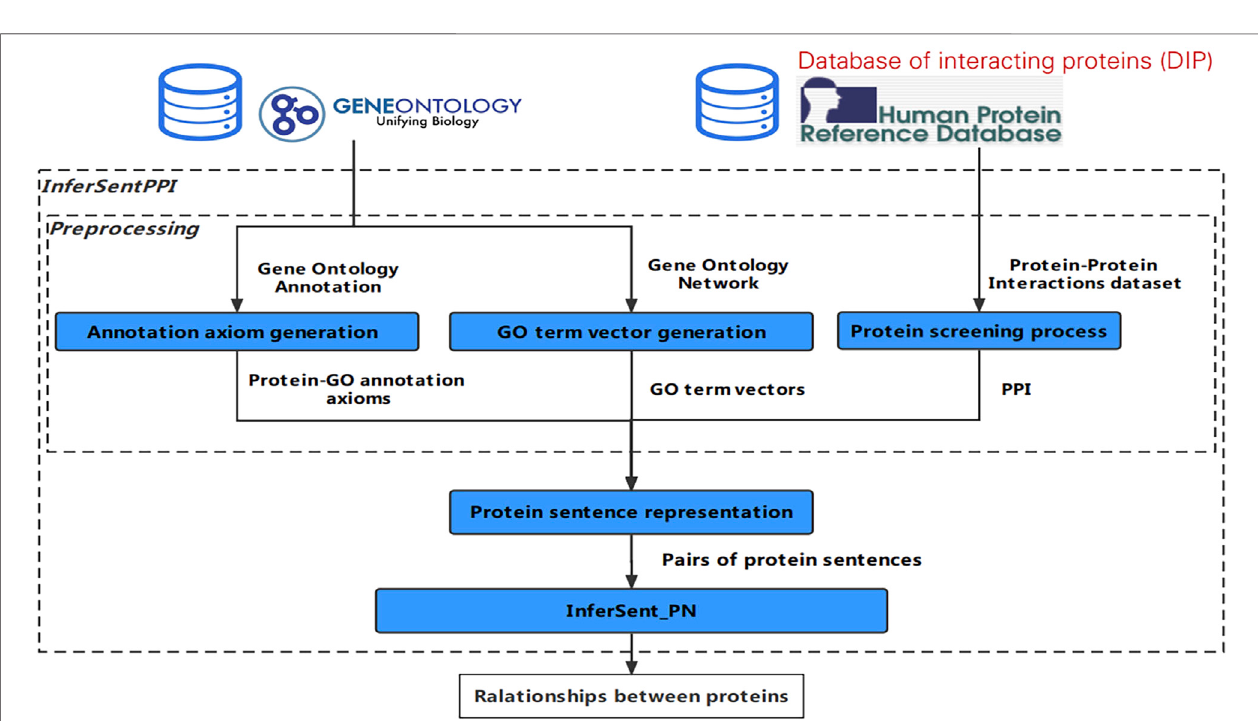
FIGURE 2 | The work fl ow of the annotation axiom